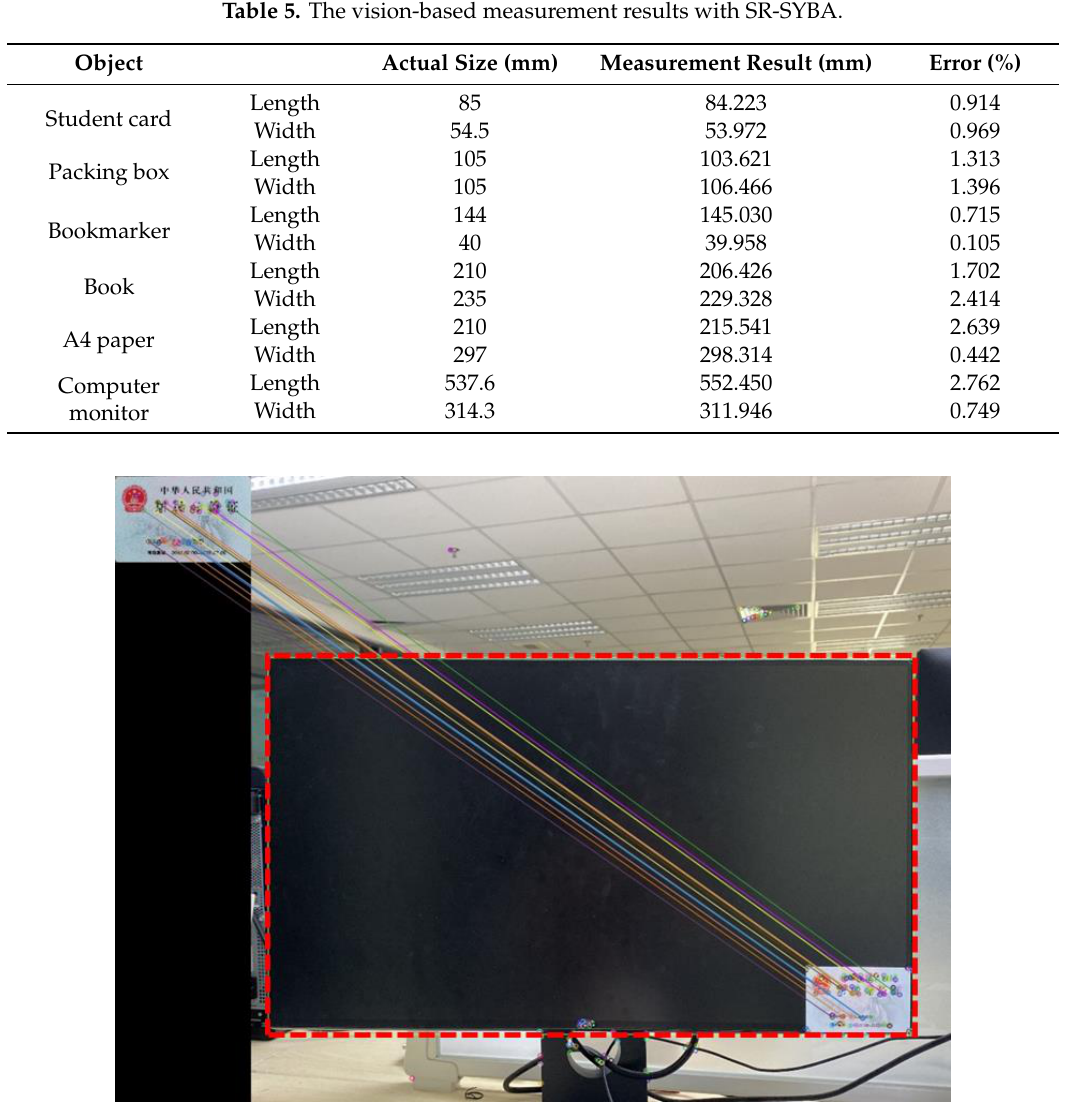
Figure 17. An example of the matching result for a vision-based measurement task.